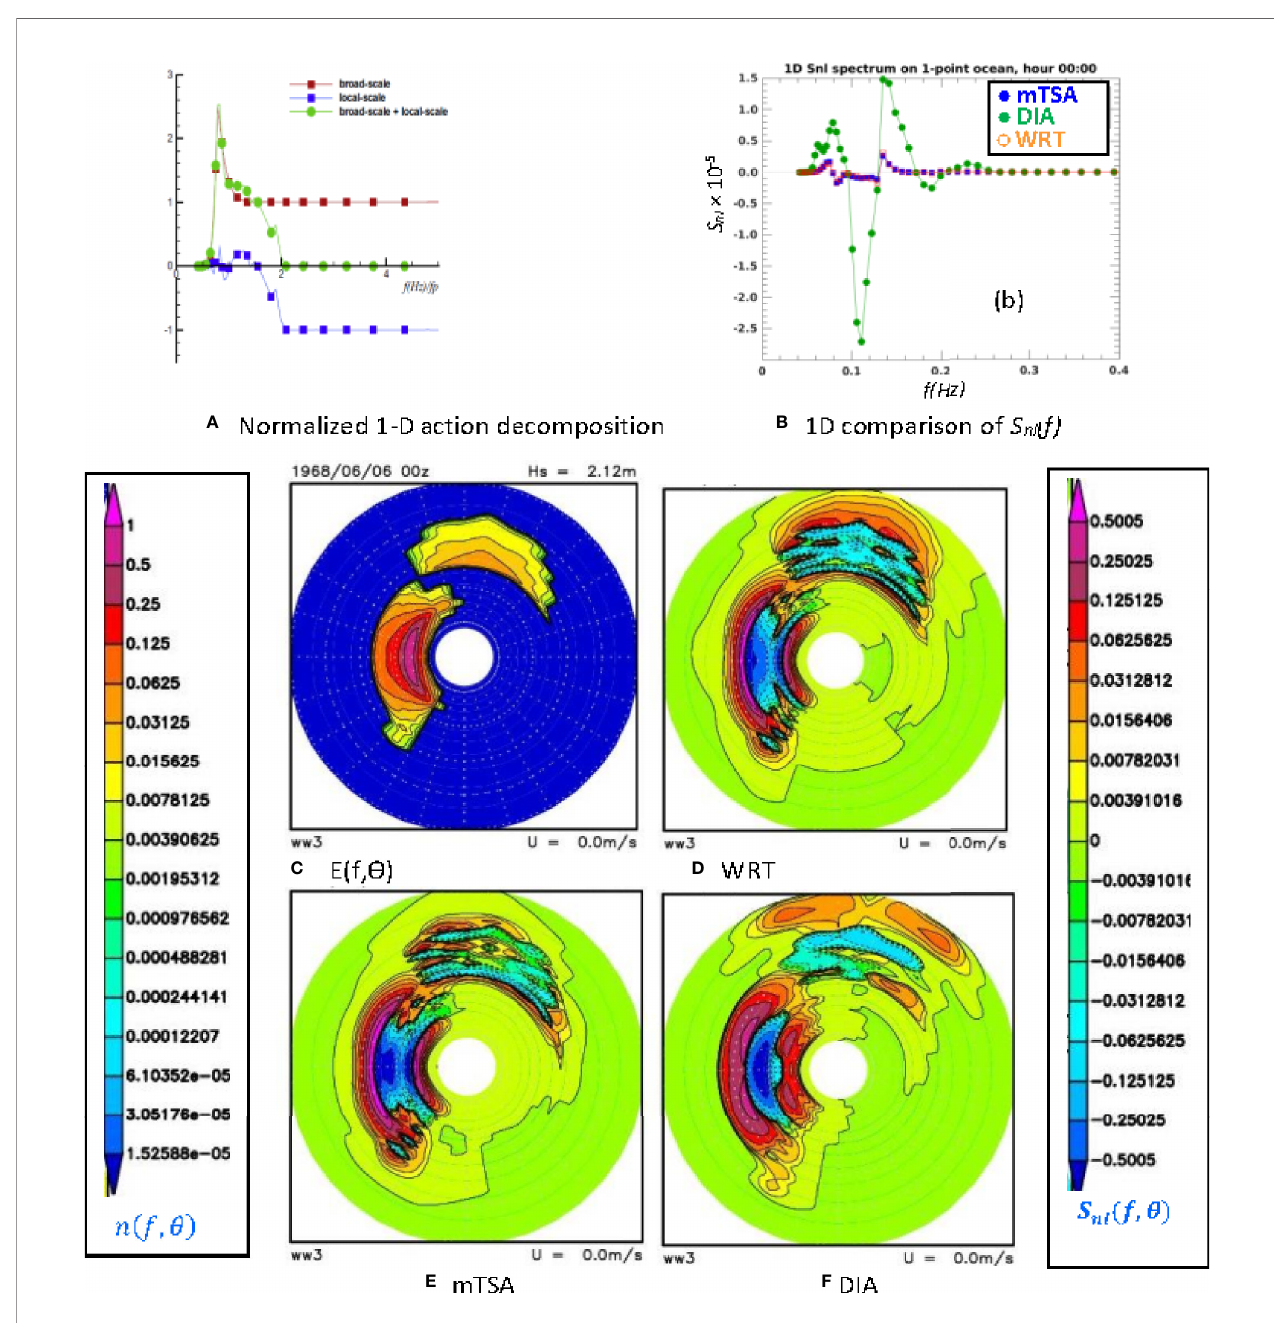
FIGURE 1 | JONSWAP spectrum with cos 2 q directional distribution for g =3.3 and secondary shear spectrum showing (A) decomposition into broad-scale and local-scale terms normalized by the f 4 equilibrium range variation, (B) 1-d variation if DIA, WRT and mTSA (units: m 2 ), (C) 2-d action density n i , (D) S nl ( f , q ) results for WRT, (E) mTSA, and (F) DIA. Color-bar for DIA, mTSA and WRT scales to ±3.13×10 -3 , ±3.10×10 -4 , and ±2.60×10 -4 , respectively. Color-bar for n ( f , q ) scales to 13.3. Other parameters are